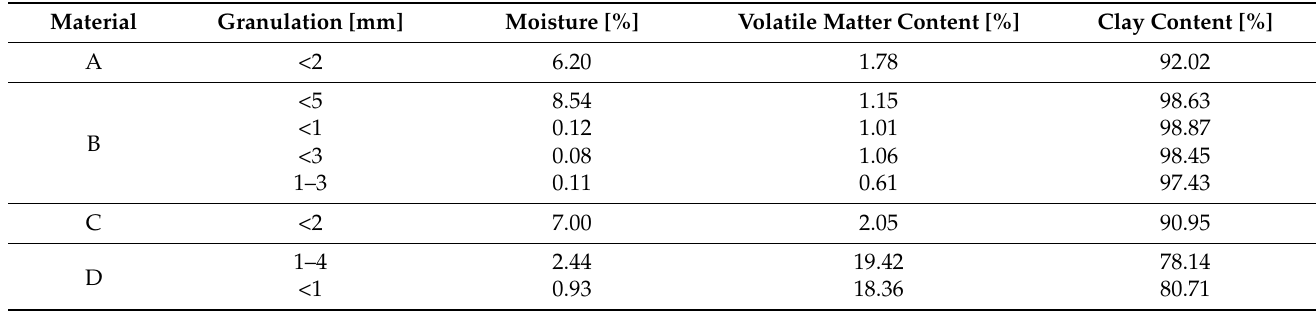
Table 2. Results of technical analysis of clay raw materials.